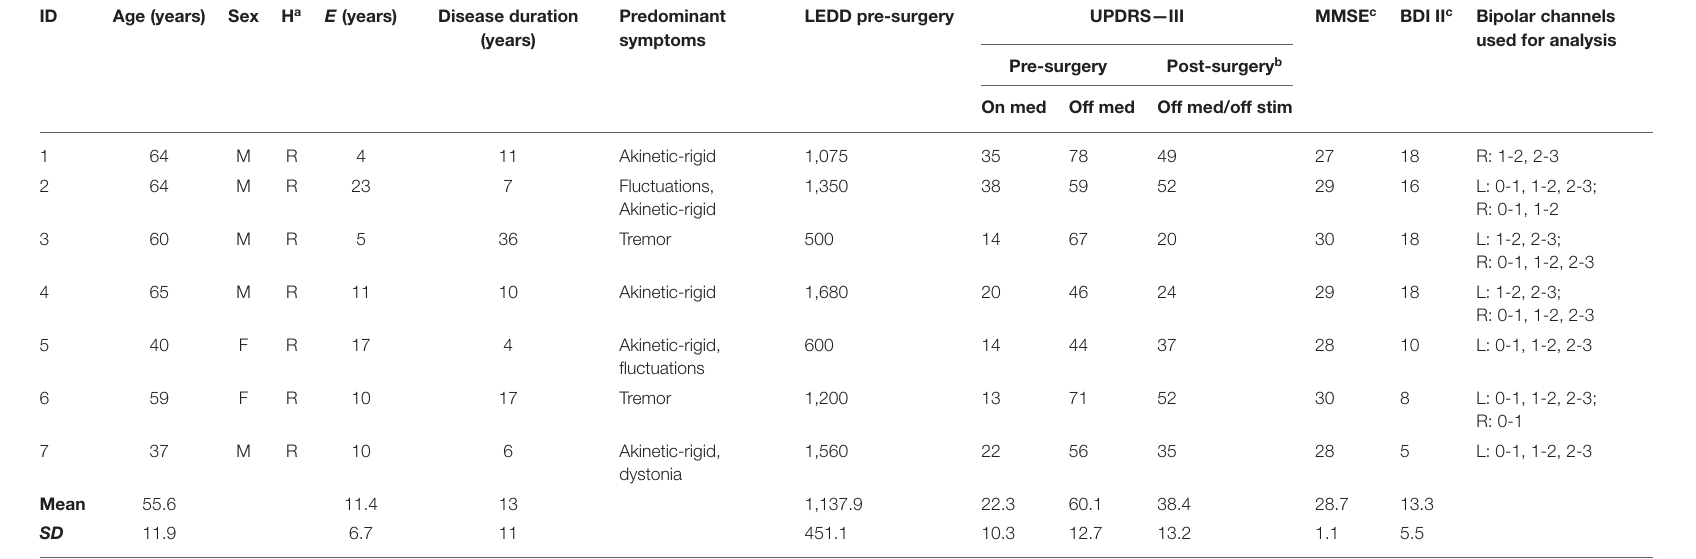
H, Handedness; E, Education; LEDD, levodopa-equivalent daily dose in mg (33); UPDRS III, Unified Parkinson’s Disease Ratings Scale motor part III; on-med, with dopaminergic treatment; off-med, without dopaminergic treatment; off-stim, with STN DBS switched off; MMSE, Mini-Mental State Examination; BDI II, Beck Depression Inventory; F, female; M, male; R, right; L, left; S.D., standard deviation. a Handedness was assessed with the Edinburgh Handedness Inventory (34). b Post-surgery UPDRS-III score was measured OFF medication and OFF stimulation on the day of LFP recording (2–3 days post-operative). c MMSE and BDI-II were evaluated before DBS surgery during ON-med